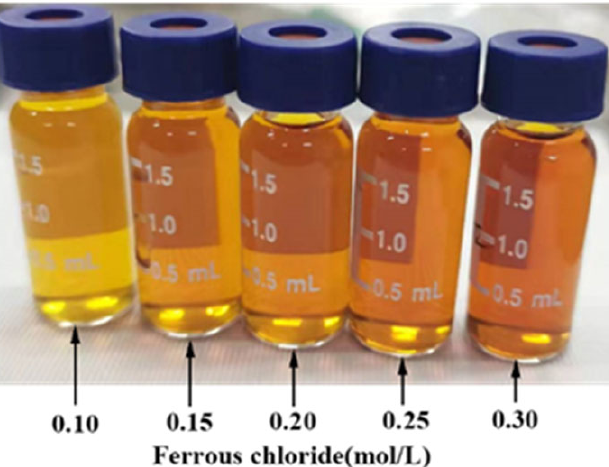
Figure 1. Solutions of progressively increasing concentration of iron (II) chloride from left to right with a concentration of 0.175 mol/L ammonium metatungstate. Table 1. The 25 groups under the Taguchi design.